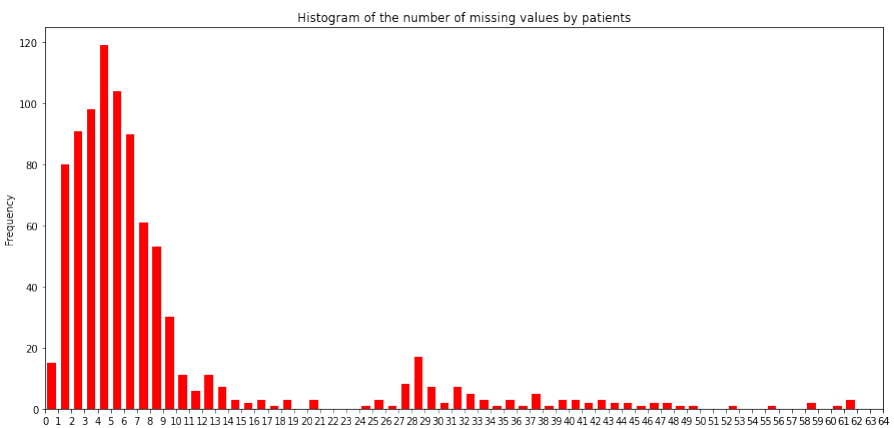
Figure 1. Histogram of the number of missing values by patients.